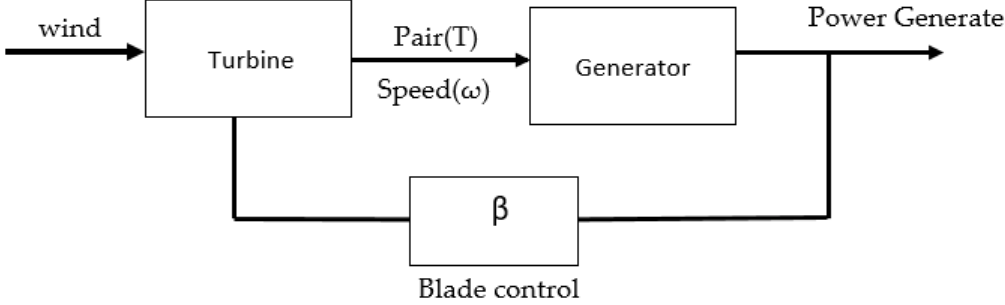
Figure 8. Generic scheme of energy conversion.